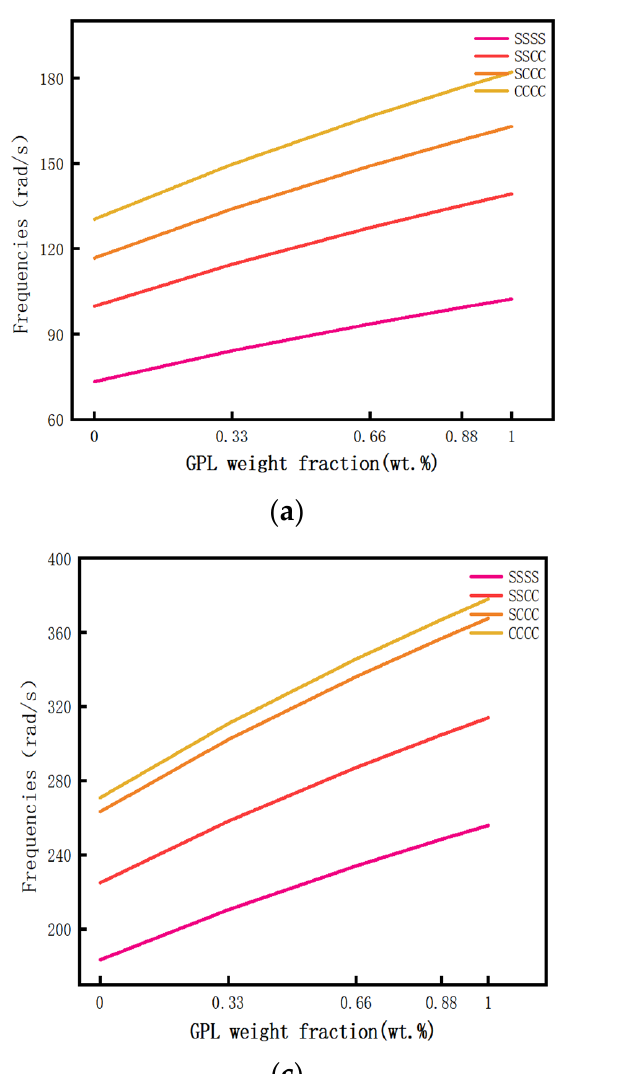
Table A3 of Appendix